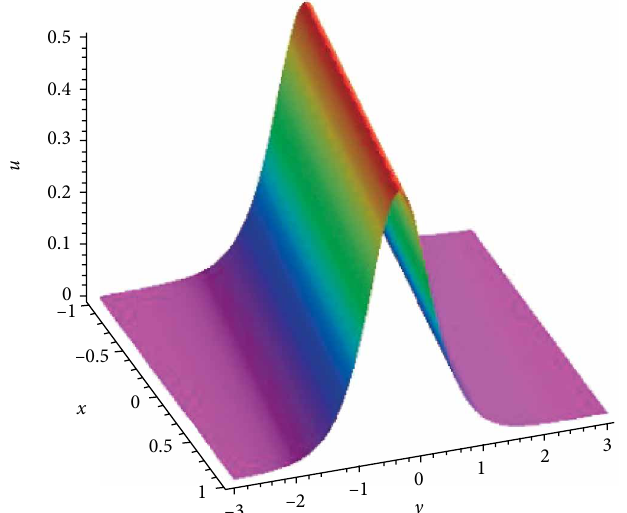
Figure 1: Line-soliton solution of the KPIIESCS for